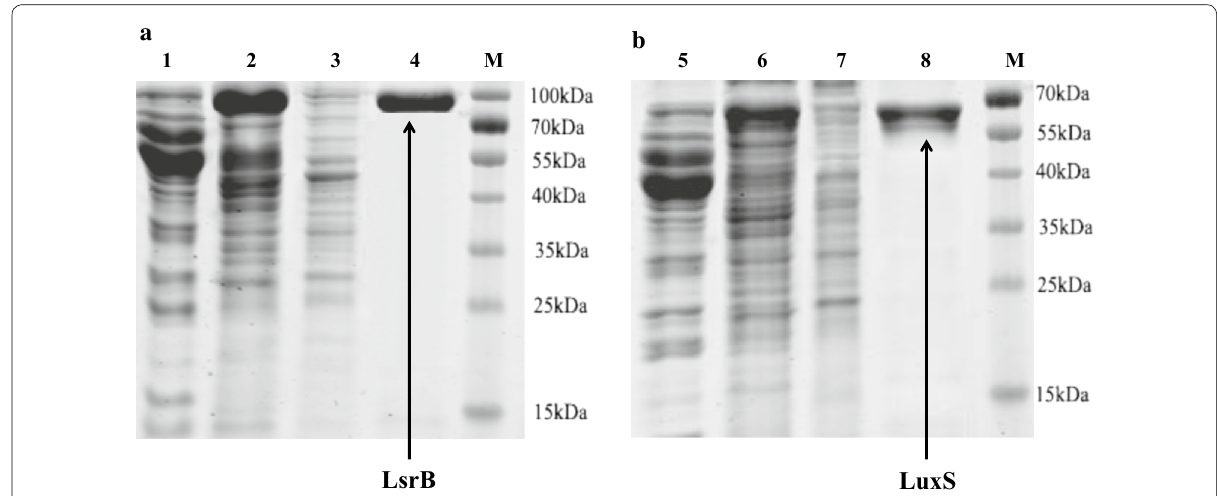
Fig. 4 SDS-PAGE analysis of total cellular proteins and purified fusion proteins from BL21∆luxS cells. Lane 1 and lane 5: SDS-PAGE analysis of total cellular proteins from BL21∆luxS containing pCold TF (serve as negative control). Lane 2 and lane 6: SDS-PAGE analysis of total cellular proteins con- taining expression plasmids pCold-TF-lsrB ( a ) and pCold-TF-luxS ( b ), respectively. Lane 3 and lane 7: SDS-PAGE analysis of total precipitation proteins containing expression plasmids pCold-TF-lsrB and pCold-TF-luxS, respectively. Lane 4 and lane 8: elution of the LsrB and LuxS purified fusion protein from the affinity column,